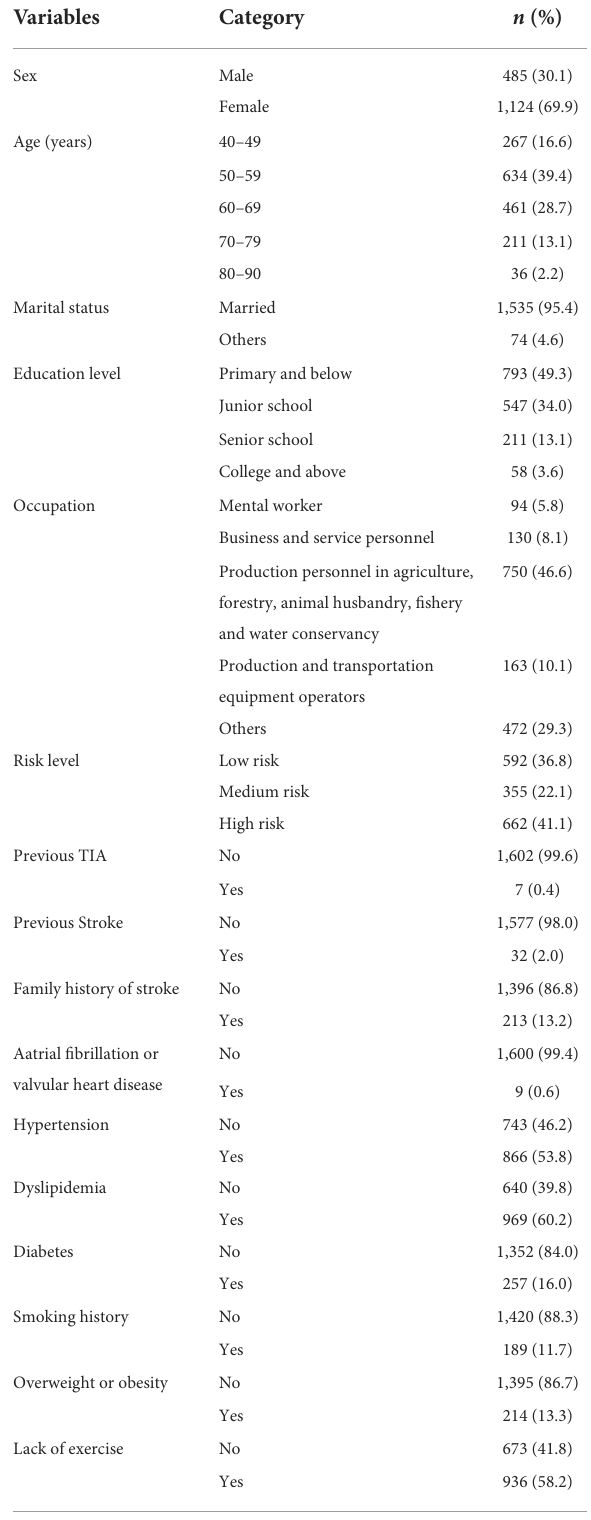
TABLE 1 Baseline characteristics of the vaccinated participants ( n =